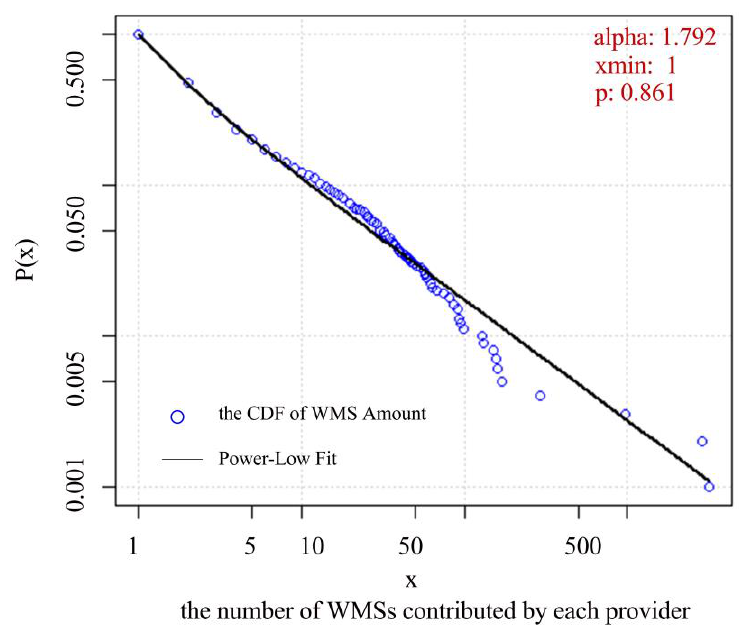
Figure 7. Log-log plot of the Cumulative Density Functions (CDF) p(x) for the number of WMSs contributed by each provider according to a discrete power law with α = 1.792 and 𝑥 𝑚𝑖𝑛 = 1 . Table 2. Top ten service providers in the monitored